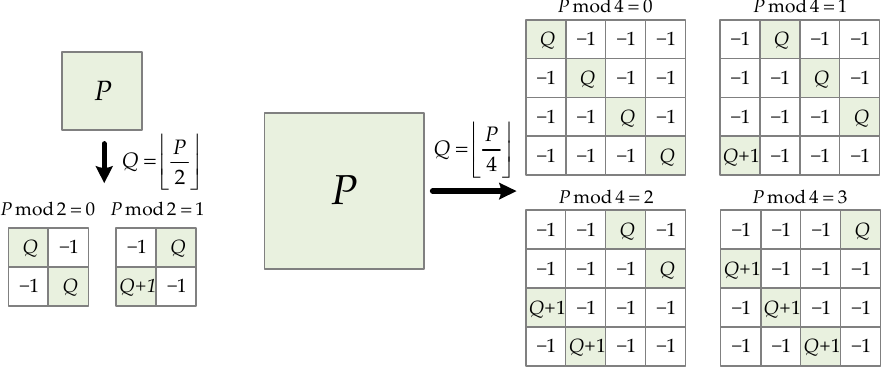
Figure 9. General circulant permutation matrix splitting results for D = 2 and D = 4. P is the shift value from the exponent matrix. Exponent matrix entry value − 1 represents a zero submatrix.